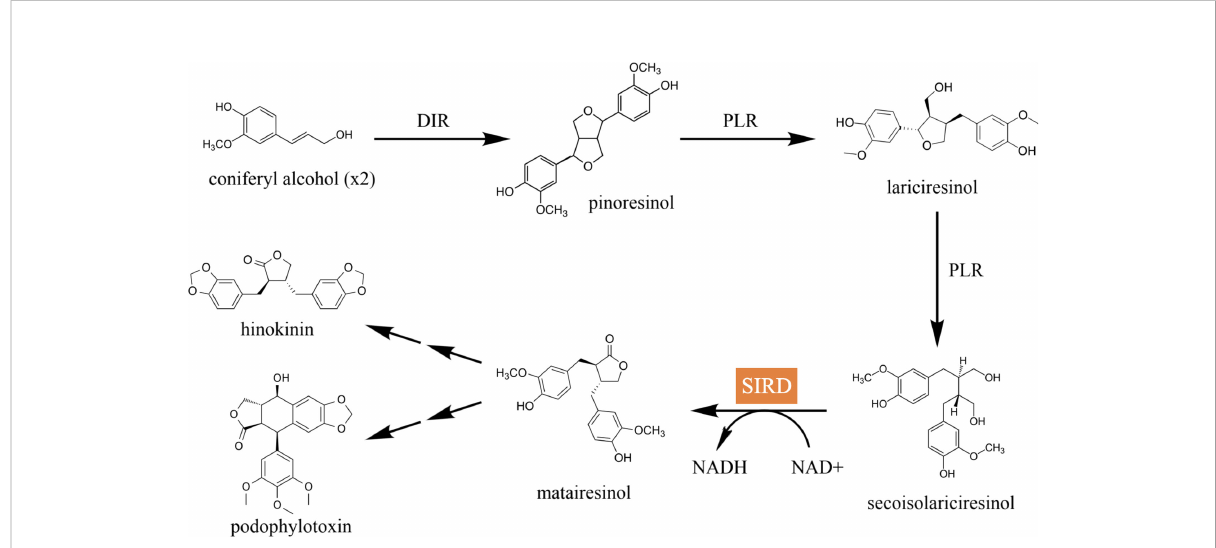
FIGURE 1 The major lignan biosynthetic pathway in plants. Coniferyl alcohol is dimerized by DIR into pinoresinol, which is then converted into lariciresinol and secoisolariciresinol in a step-wise manner catalyzed by PLR. Secoisolariciresinol is converted into matairesinol by SIRD, which is eventually converted into pharmacologically active compounds such as hinokinin and